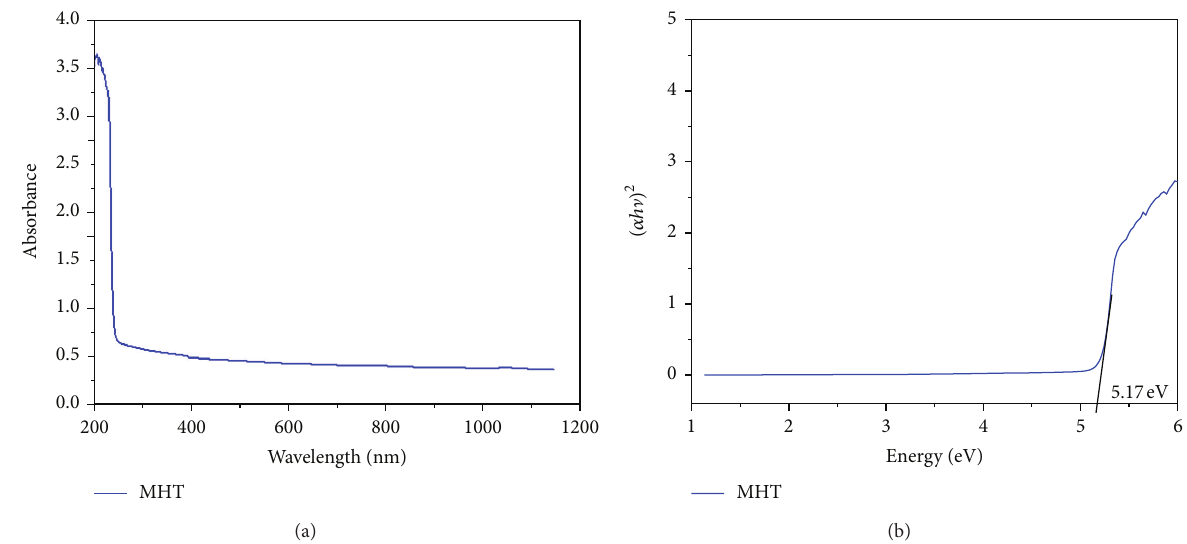
Figure 4: (a) Absorbance spectrum of MHT. (b) Plot of ( 𝛼ℎ ] ) 2 versus photon energy of MHT.